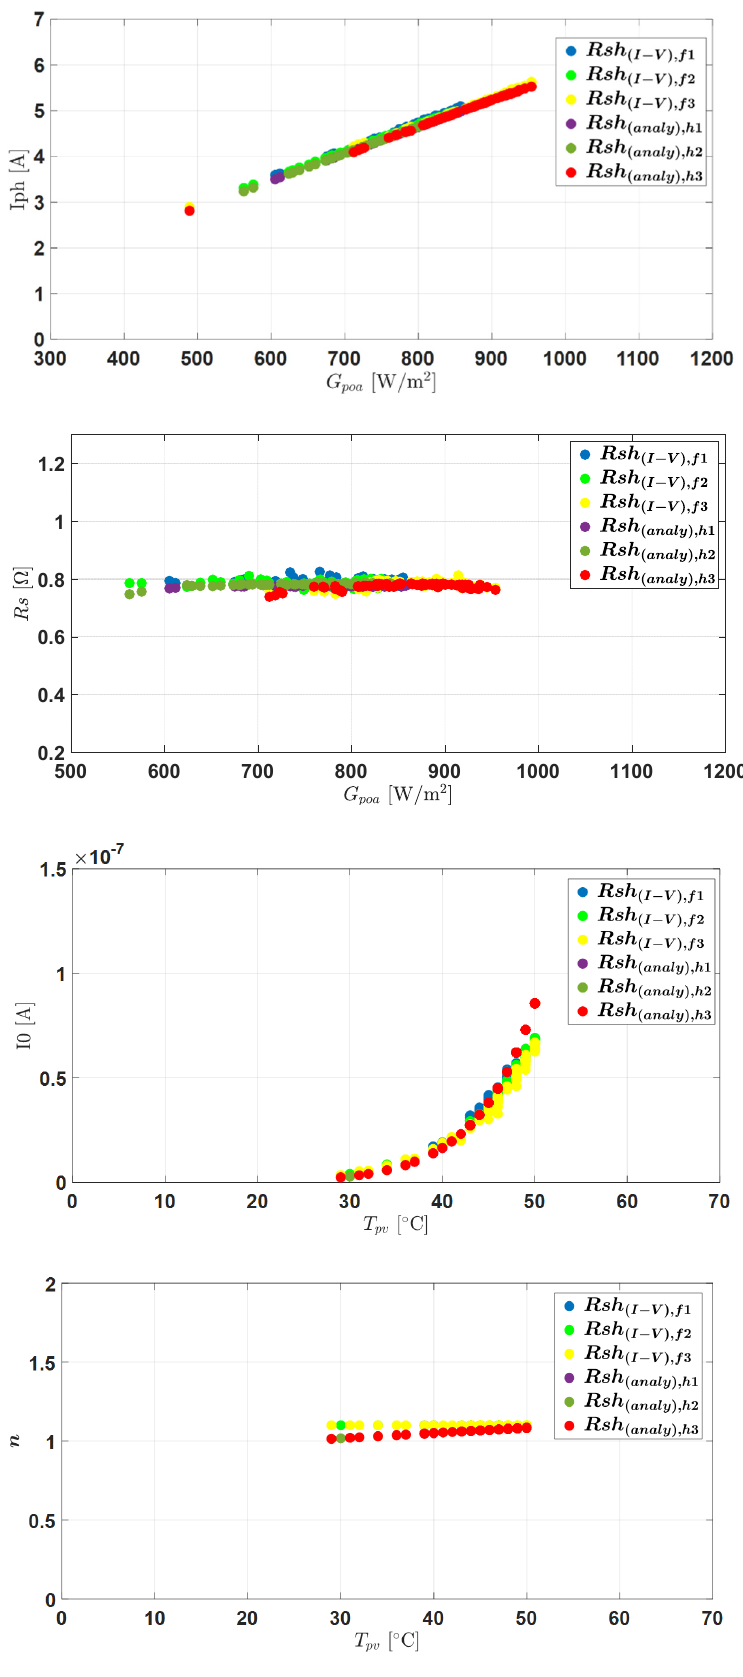
Figure 28. Effect of 𝑹 𝒔𝒉 degradation on the other parameters of the SDM.